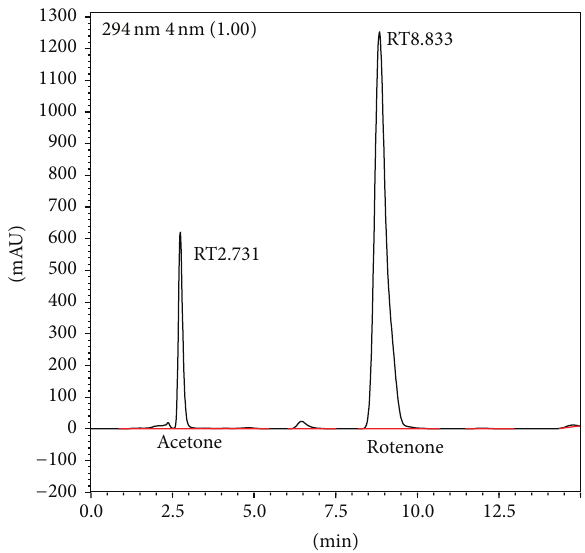
Figure 6: Chromatogram of rotenone standard.